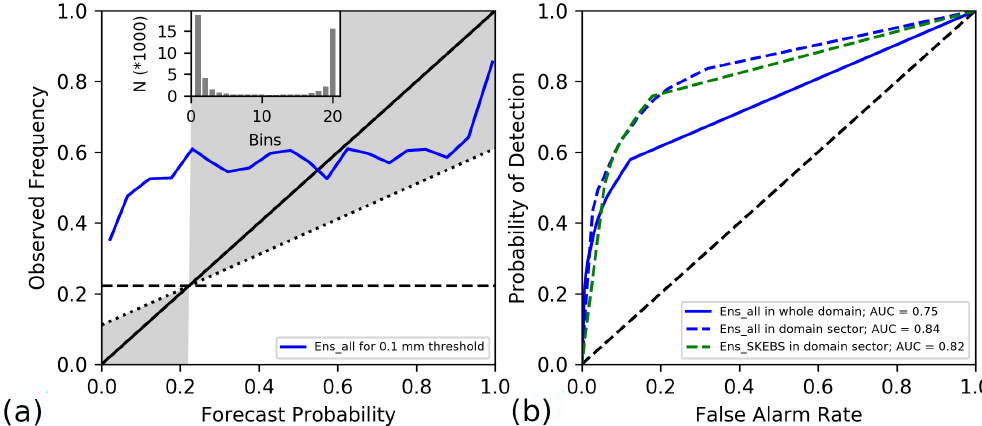
Figure 14. ( a ) the reliability diagram and ( b ) the ROC plot for precipitation using hourly IMERG data as observations for the WRF domain. Blue lines correspond to the overall ensemble, while the green one are for the ensemble considering SKEBS members only. Valid for the simulation period starting at 00Z on 27 February